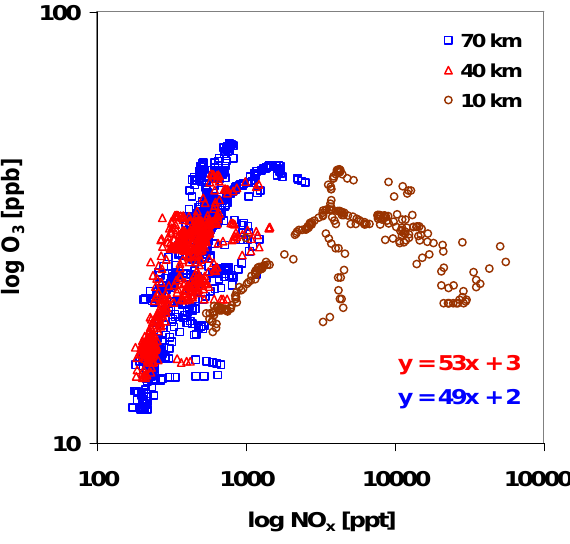
Fig. 9. Absolute values of O 3 versus NO x during Flight #11 (al- titudes in the range of 230–280m, with respective high degree of short-term variability due to the proximity of these flight transects to the surface sources). High NO x mixing ratios observed in the centre of the plume at 10km distance of Manaus were associated with low O 3 enhancement (see Fig. 8). Slopes of a linear regression based on the reduced-major-axis (RMA, linear) regression method are given only for 40 and 70km distance.